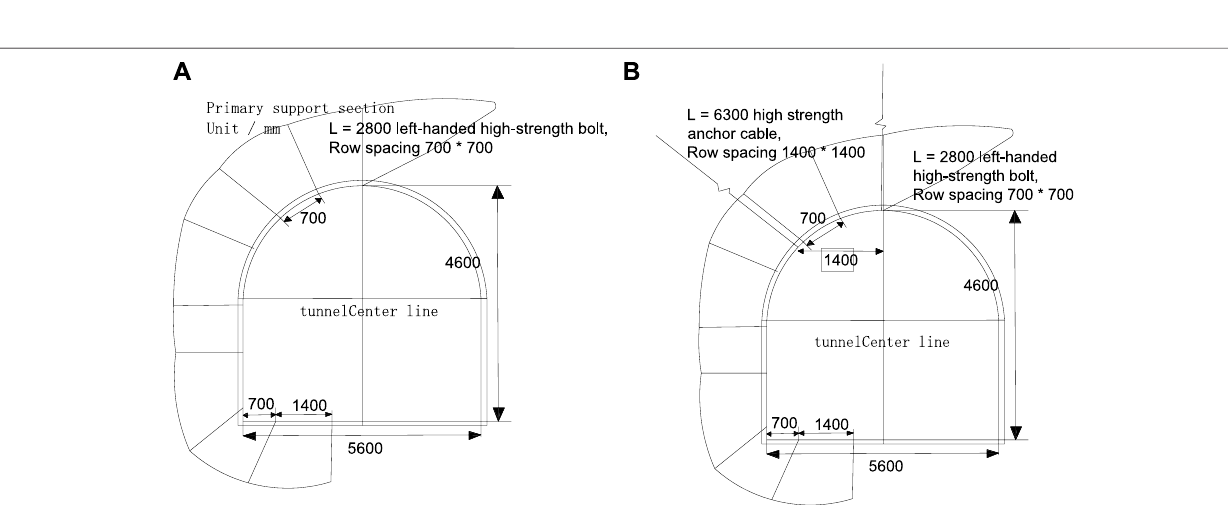
FIGURE 9 | Field investigation on the deformation status of the 11 coal belt roadway.